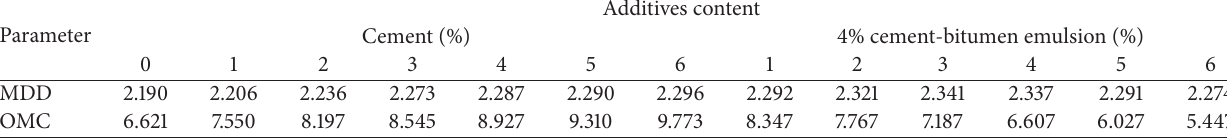
Table 4: MDD and OMC of CTB, CBETB, and mixture without